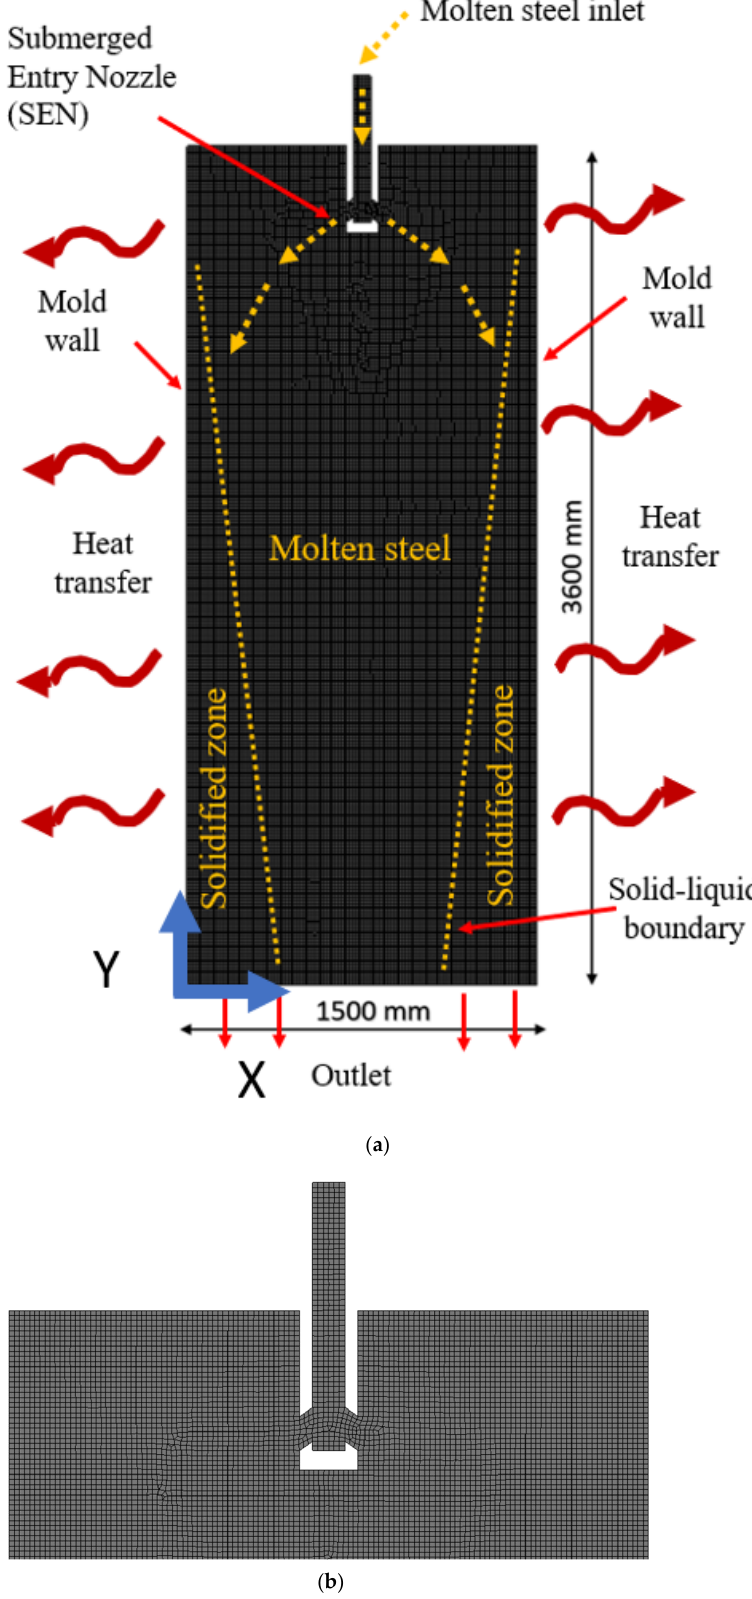
Figure 2. ( a ) Schematic of the domain and ( b ) domain meshing. The specifics of the grid independence test are shown in Figure 2b (the approximate number of elements is illustrated). It was determined that, in comparison to a greater number of elements, about 200,000 elements produced outcomes that were satisfactory (see Figure 3). According to the grid independence test, the domain’s mid-vertical plane had a mean velocity change of no more than 5%. However, adding more items resulted in a noticeable increase in computing time. By taking an average temperature reading at the mid-vertical plane of the domain, the convergence of the solution was investigated. From Ref. [28], it was possible to determine the thermo-physical characteristics of molten steel and alumina inclusions. Figure 3. Grid independence test. Equation (9) was employed in the simulation to account for the surface tension cor- relation between molten steel and alumina. Equation (10) was also used in a computer model to measure the interfacial tension between molten steel and alumina inclusions. We used empirical relationships from Jeong et al. [11]. They conducted experiments to deter- mine the surface tension of SPFH590 steel and the interfacial tension of SPFH590 steel and